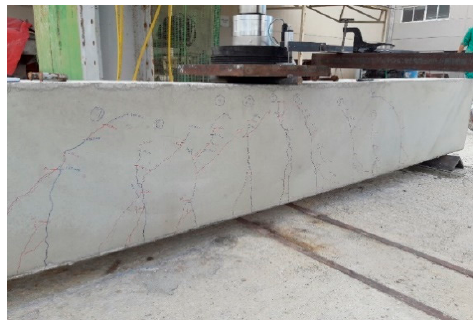
Figure 21. Visual control of cracking in the 300 × 500 mm beam.